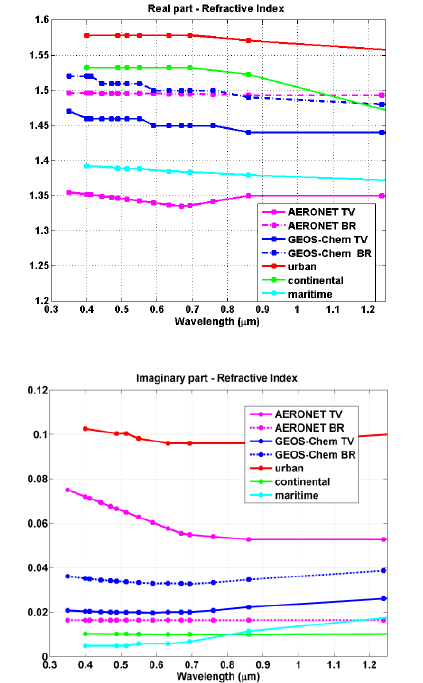
Figure 3. Single scattering albedo (SSA ) retrieved from AERONET and simulated with 6SV using microphysical properties from the five models.